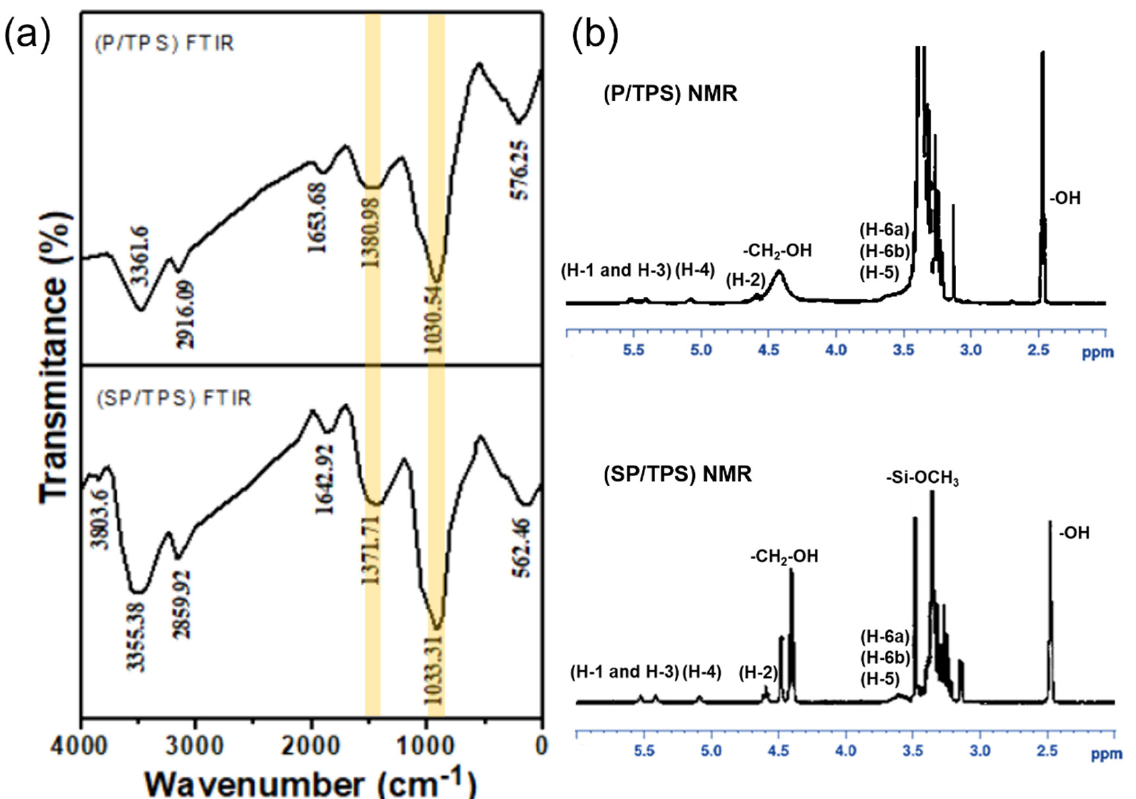
Figure 1. Schematic of chemical modification for analysis of TPS functional groups. ( a ) FTIR of (P/TPS) and (SP/TPS). ( b ) NMR of (P/TPS) and (SP/TPS). H NMR Investigation of (P/TPS) and